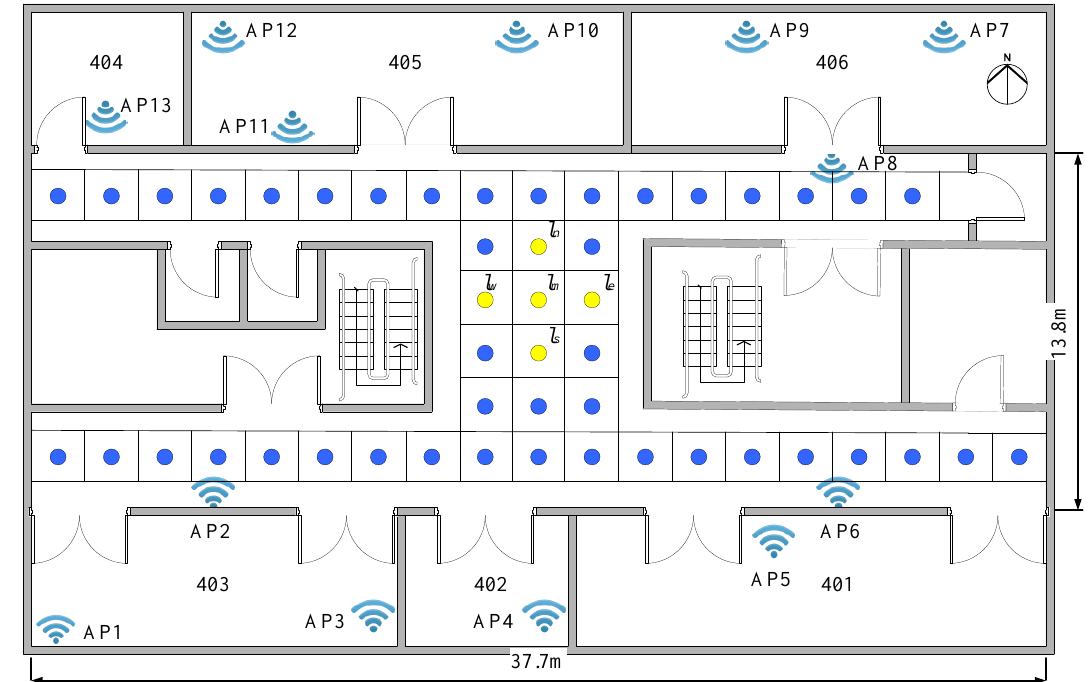
Figure 4. The layout of the fourth floor of the YiFu building.